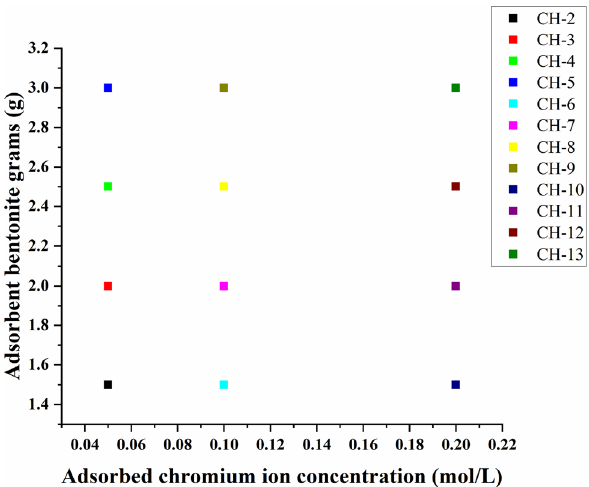
Figure 9. Diagram of the relationship between the weight of bentonite samples and the concentration of the adsorption solution of trivalent chromium ions for different sample